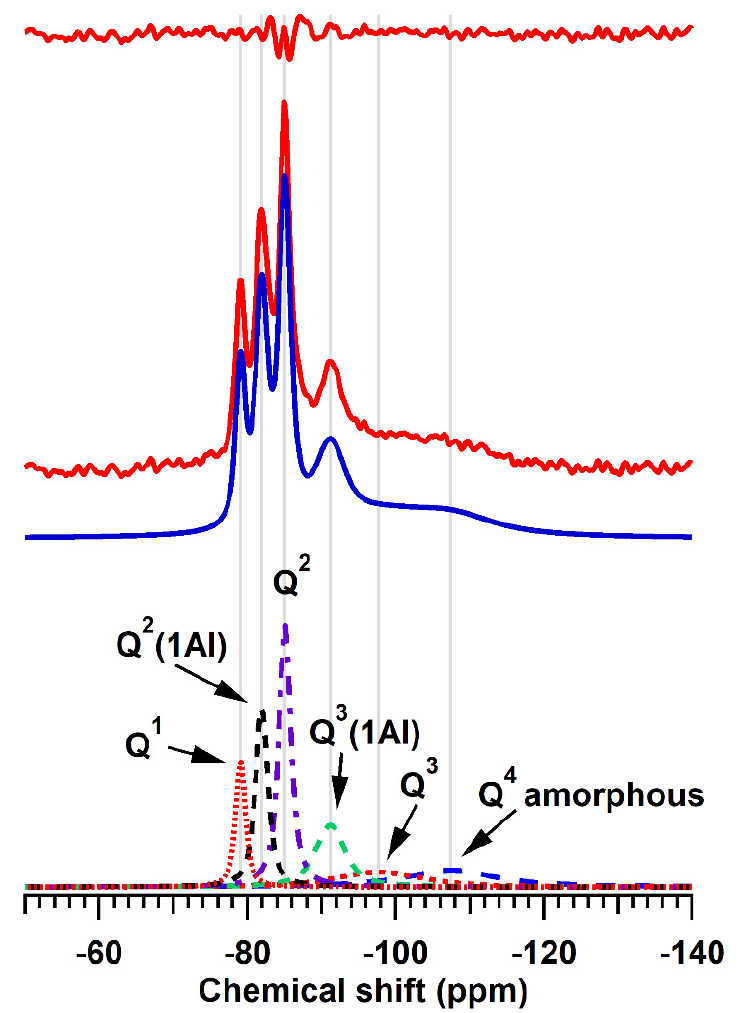
Figure 4. 29 Si MAS NMR spectrum of product TOB-7. The experimental and calculated spectra are depicted, respectively, as continuous red and blue lines. The individually resolved resonances are presented as dashed lines and the residual between the calculated and experimental spectra is shown in red at the top of the figure. Table 3. Relative abundance of Q n species and their chemical shifts, amorphous-content, mean alu- minosilicate chain length (MCL), and Al:Si ratio of tobermorite in TOB-7. Parameter